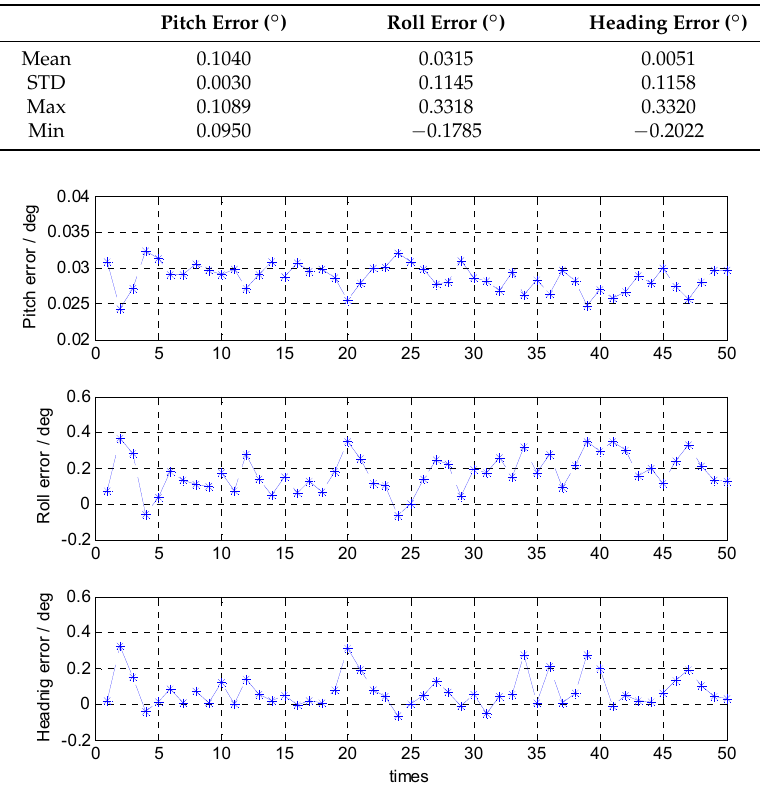
Figure 6. Attitude errors of the coarse alignment with the severe sea condition.